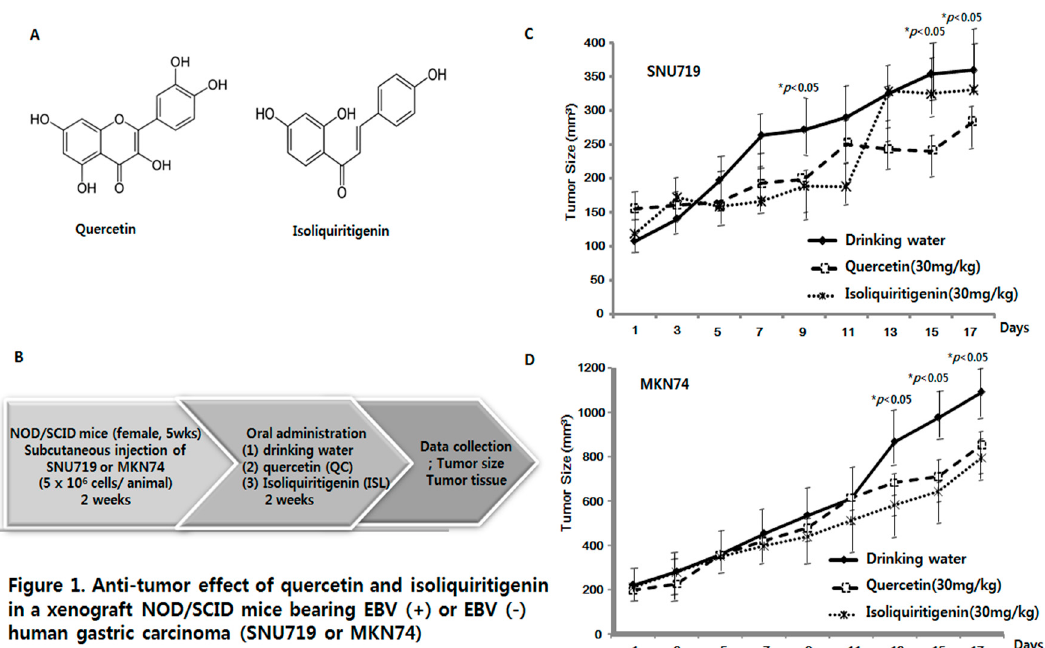
Figure 1. Anti-tumor effects of quercetin and isoliquiritigenin in xenograft NOD/SCID mice bearing EBV(+) or EBV( − ) human gastric carcinoma (SNU719 or MKN74) NOD/SCID mice were randomly divided into two groups. One group was implanted with EBV(+) human gastric carcinoma, SNU719, and the other group was implanted with EBV( − ) human gastric carcinoma, MKN74. These two groups were then subdivided into three subgroups ( n = 5/subgroup). Two weeks after implantation, mice were orally administrated (in drinking water) quercetin (QC, 30 mg/kg/day) or isoliquiritigenin (ISL, 30 mg/kg/day). ( A ) The structures of quercetin and isoliquiritigenin; ( B ) The study design of the animal experiment; ( C ) Tumor sizes in animals injected with EBV(+) positive carcinoma (SNU719) or ( D ) EBV( − ) carcinoma (MKN74).